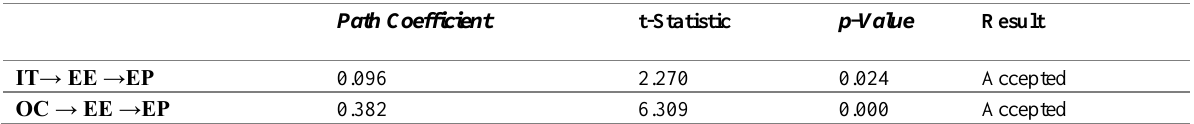
Table 5: Indirect Hypothesis